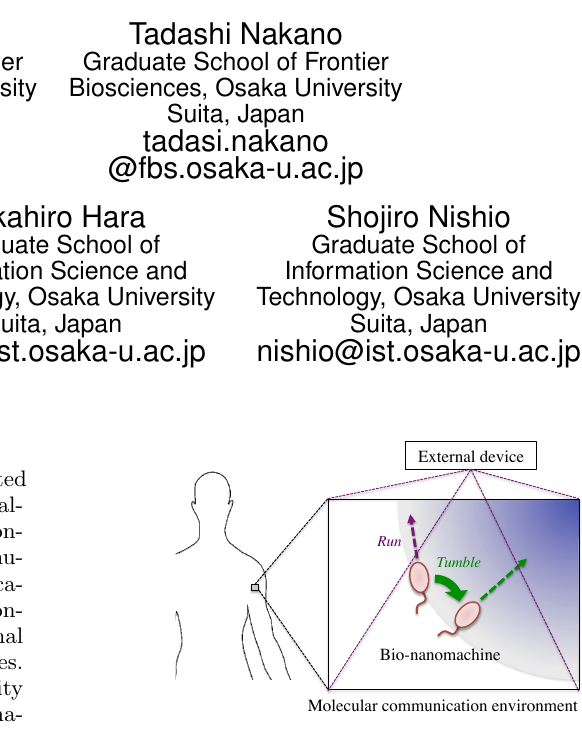
Figure 1: Interaction between an external